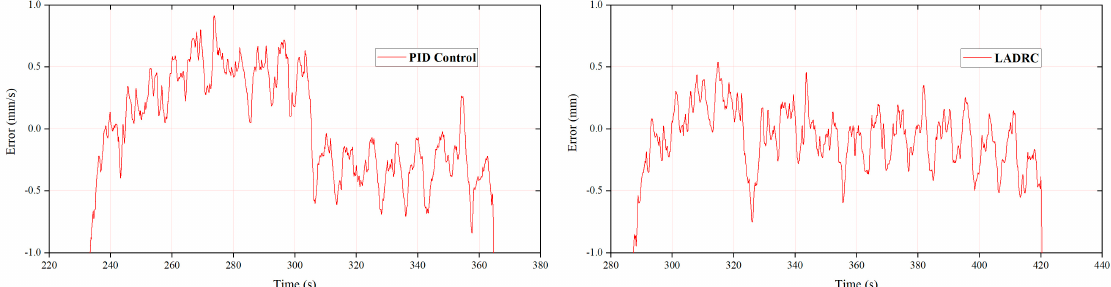
Figure 23. Speed error of cylinder #2 during folding.